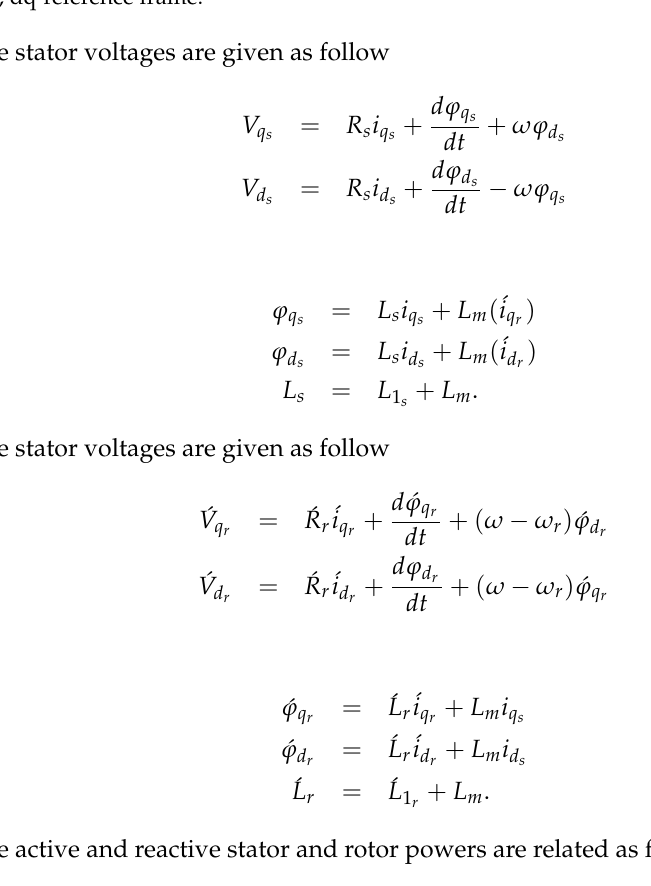
Figure 4. Electrical circuit Diagram of Wound Rotor (DFIG) and Single Cage (SCIG) in the arbitrary two-axis, dq-reference